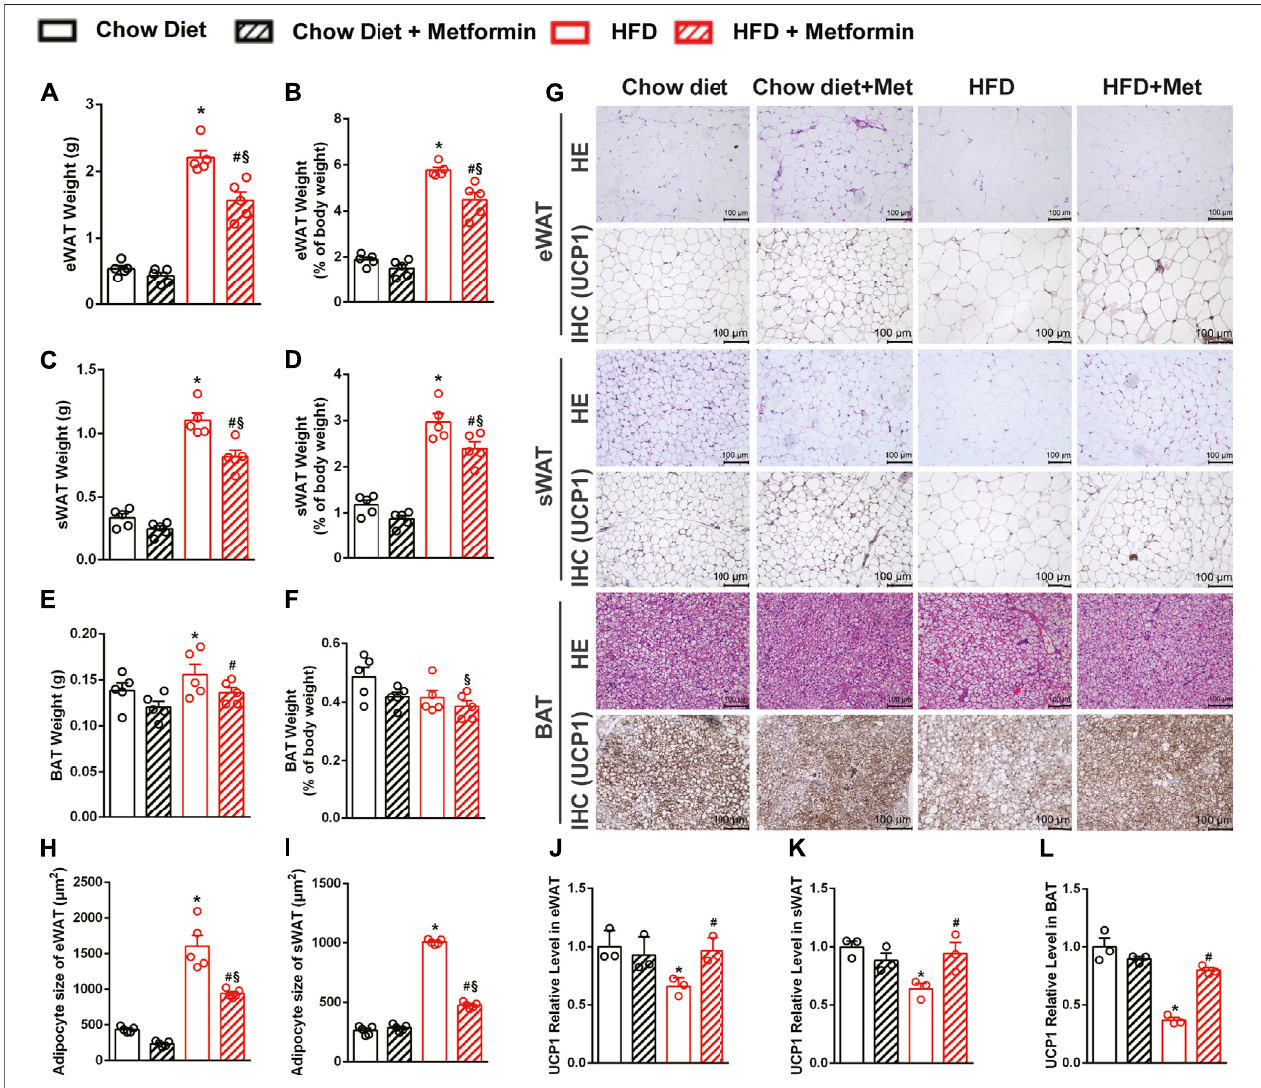
FIGURE 2 | Metformin induces beiging of WAT and activation of BAT in DIO mice. In DIO mice, the weight of (A) epididymal adipose tissue (eWAT), (C) subcutaneous adipose tissue (sWAT), (E) brown adipose tissue (BAT) were signi fi cantly reduced by metformin ( p ＜ 0.05). Metformin also reduced the percent of (B) eWAT and (D) sWAT to body weight ( p ＜ 0.05) while had no effect on the percent of (F) BAT ( p > 0.05). (G) The H&E staining and the uncoupling protein 1 (UCP1) immunohistochemical staining of adipose tissue with x200 magni fi cation showed that metformin induced beiging of WAT and activation of BAT, which were con fi rmedbytheresultsofquanti fi cationofUCP1proteinexpressionsin (J) eWAT, (K) sWAT,and (L) BAT( p ＜ 0.05).Thesizeofadipocyteswassigni fi cantlyreducedin (H) eWAT and (I) sWAT by metformin ( p ＜ 0.05). Data are shown as mean ± SEM. * p ＜ 0.05, HFD group vs Chow diet group; # p ＜ 0.05, HFD group vs. HFD + Metformin group; § p ＜ 0.05, HFD + Metformin vs. Chow diet group.